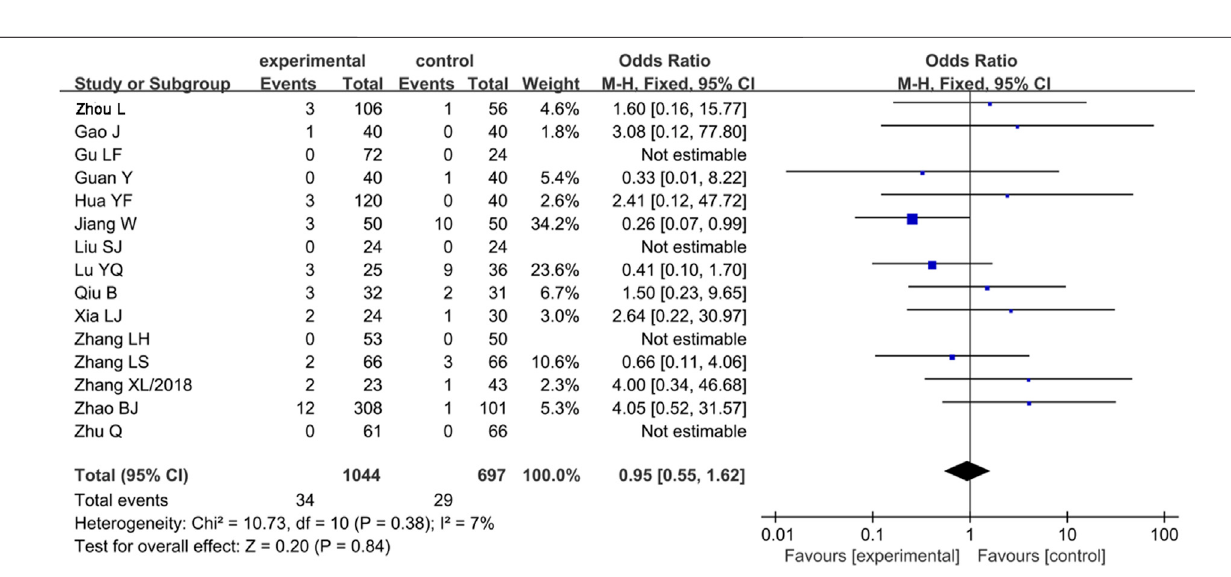
FIGURE 5 | Forest plot of ginkgo terpene lactone preparations on ADRs/ADEs; ADRs/ADEs, adverse drug reactions/adverse drug events.